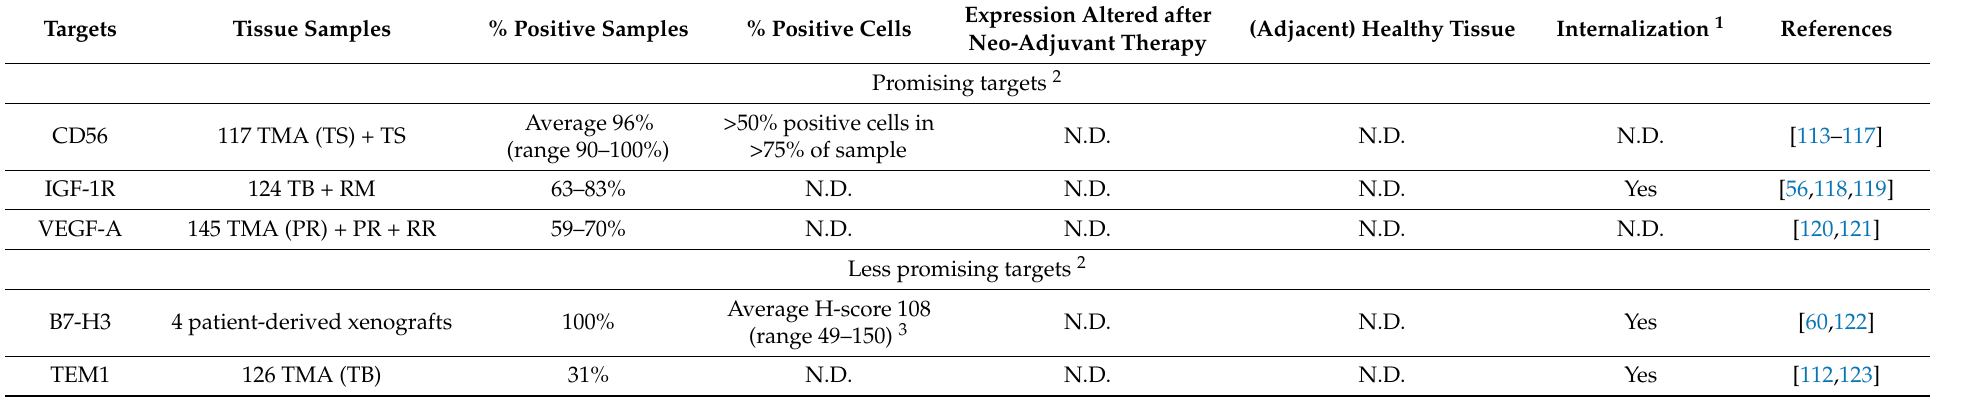
Table 3. Characteristics of targets evaluated for fluorescence-guided surgery in